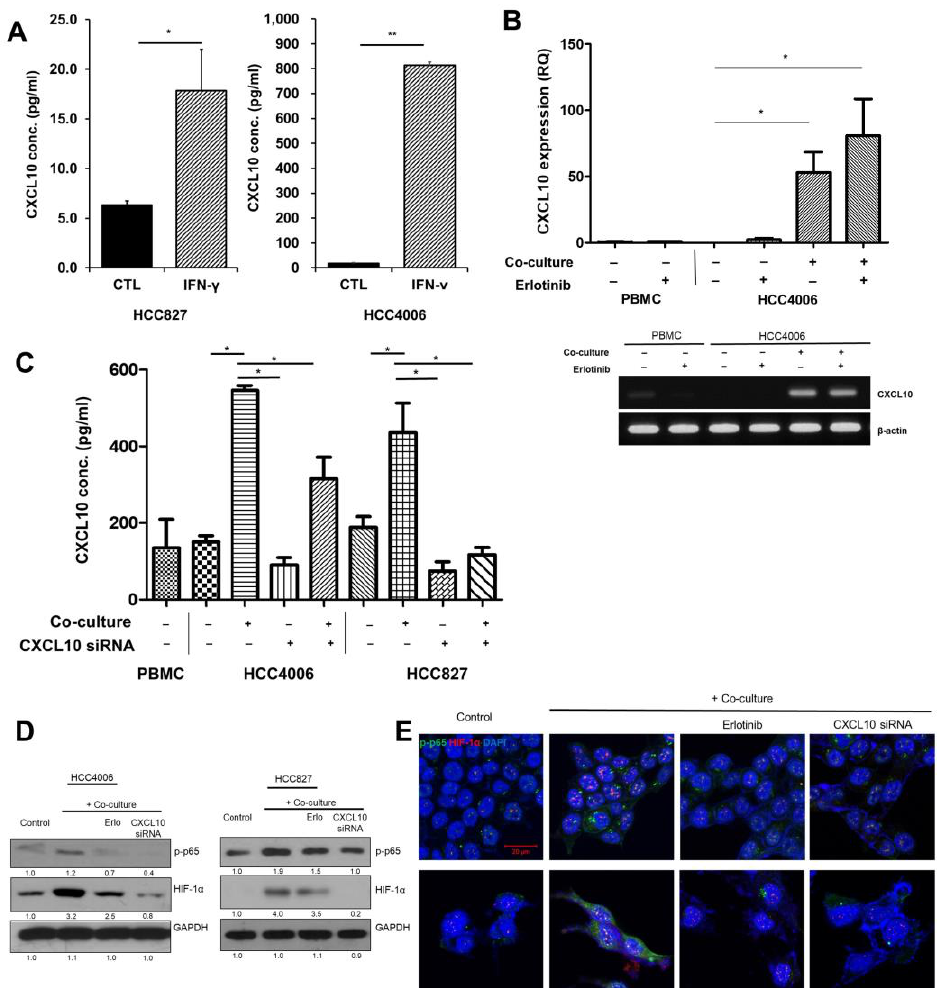
Figure 4. Autocrine activation of the CXL10/CXCR3 pathway by endogenous CXCL10 in EGFR-mutant lung cancer cells. ( A ) Supernatants collected from HCC4006 and HCC827 cells treated with 20 pg/mL IFN − γ for 72 h were analyzed using ELISA for CXCL10 (* p < 0.5 and ** p < 0.01 versus control). ( B ) Increased CXCL10 mRNA expression of HCC 4006 with coculture and treatment of EGFR-TKI. ( C – E ) HCC4006 and HCC 827 cells cocultured with activated PBMCs for 48 h and treated for 6 h with siRNA against endogenous CXCL10. ( C ) ELISA quantification for CXCL10 of supernatants from coculture with activated PBMC (* p < 0.05). ( D ) Western blot analysis of samples treated with siRNA against CXCL10. € Immunofluorescence analysis of p-p65 and HIF- 1α in cells treated with siRNA CXCL10 or erlotinib (50 nM, HCC4006 cell and 20 nM HCC827 cells). Nuclei were counterstained with DAPI (blue) for the detection of DNA. Data are presented as mean ± SD of three independent experiments. Cells were treated with 100 µM of each of the STAT3 and HIF- 1α inhibitors.